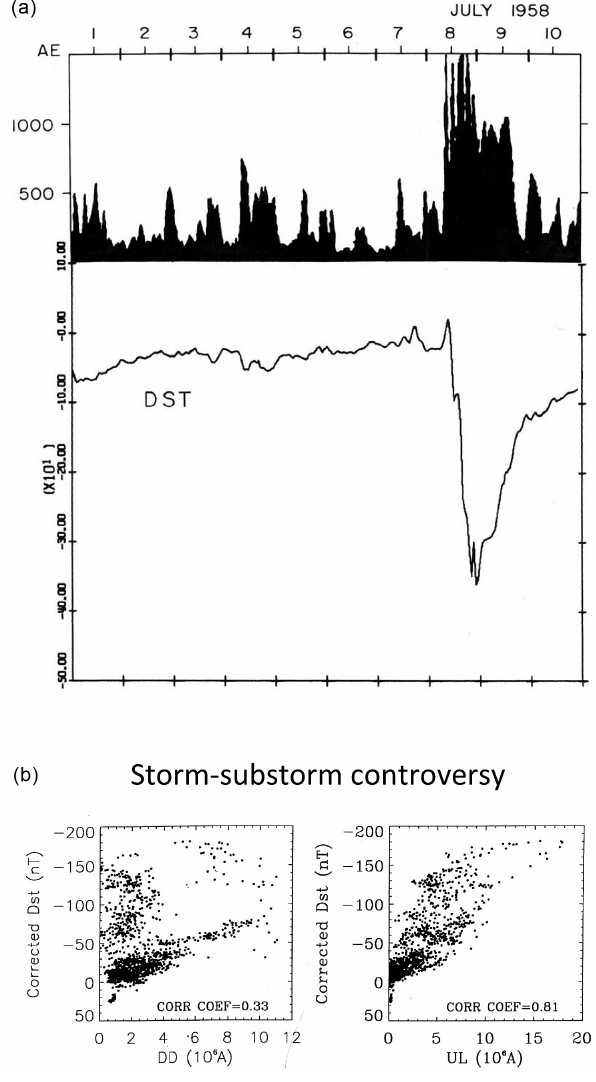
Figure 8. (a) The figure shows the simultaneous occurrence of in- tense substorms and an intense ring current. (b) The relationship between the DD current and the D st index and also between the UL current and the D st